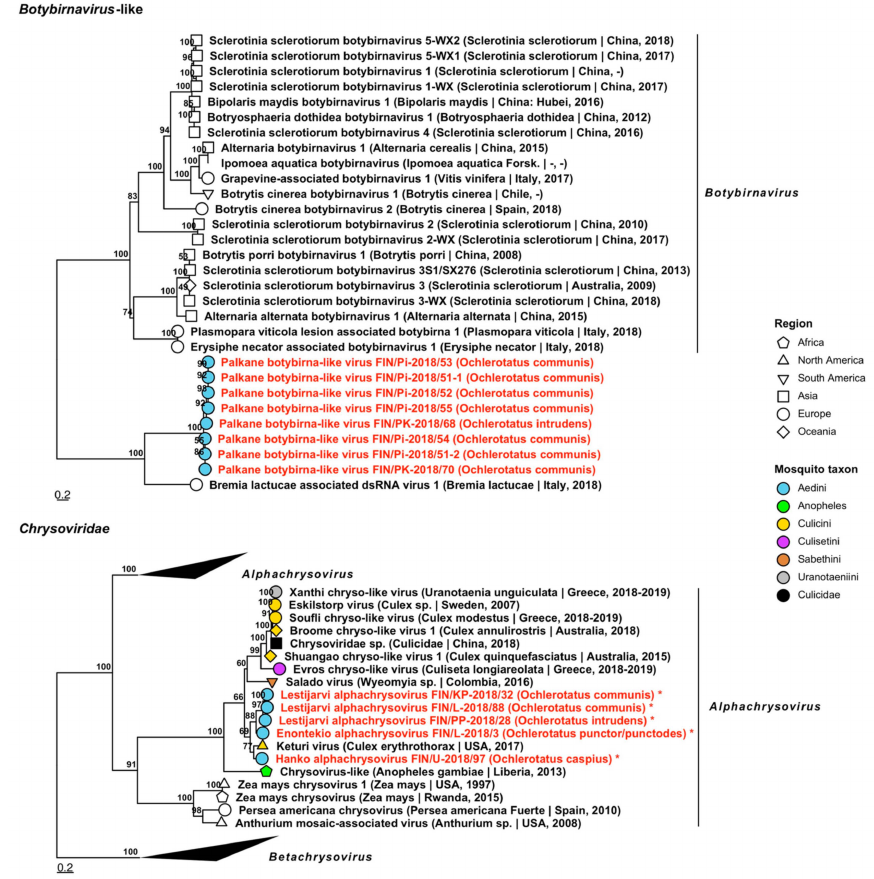
Figure 16. Maximum likelihood trees of Botybirnavirus and Chrysoviridae . Tentative novel viruses are displayed in red and the mosquito species from which they were derived are in parentheses. Sequences from GenBank are black and display the following information after the virus or species name: “(sampled organism(s)|collection country, collection year)”. Tip colours represent the tribe (Culicinae) or genus (Anophelinae) of mosquito from which viruses were obtained. Tip shape represents the continent or region from which the specimens were collected. Trees were constructed from amino acid sequences of virus polymerases >1000 nt, aligned with MAFFT and computed with IQ-TREE2 using ModelFinder and 1000 bootstraps. Asterisks denote that the complete genome was